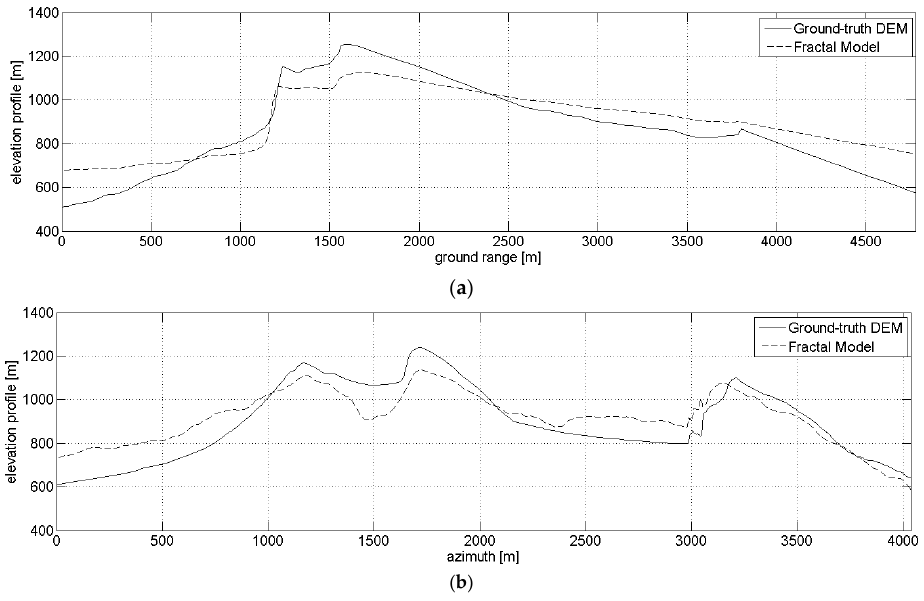
Figure 22. Reference and estimated ( a ) range and ( b ) azimuth profiles assuming a priori knowledge about starting points and estimating the additive volumetric contribution due to vegetation. Table 6. Quality measures for the actual multilook SAR image of the Vesuvius volcano. Elevation (m) Range Slope ( ◦ Error Magnitude